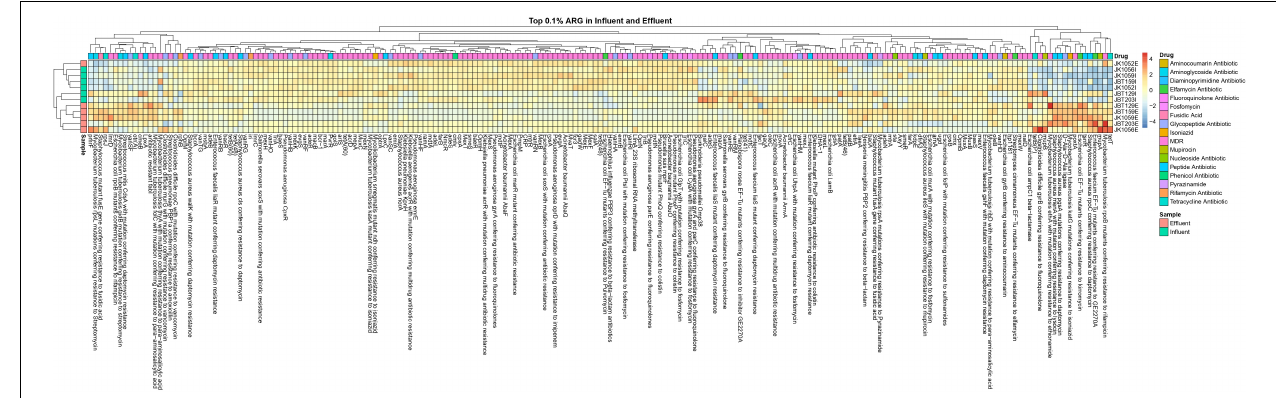
via Gephi R (cid:13) , respective to each source. The co-occurrence meta- network patterns were used to elucidate and propose potential species host of pathogenic ARG. Although both gene networks consist of 1352 nodes, the influent gene network has a smaller edges (interactions) value of 28,025 compared to the effluent gene network of 33,932 ( Figure 11 ). This information may suggest